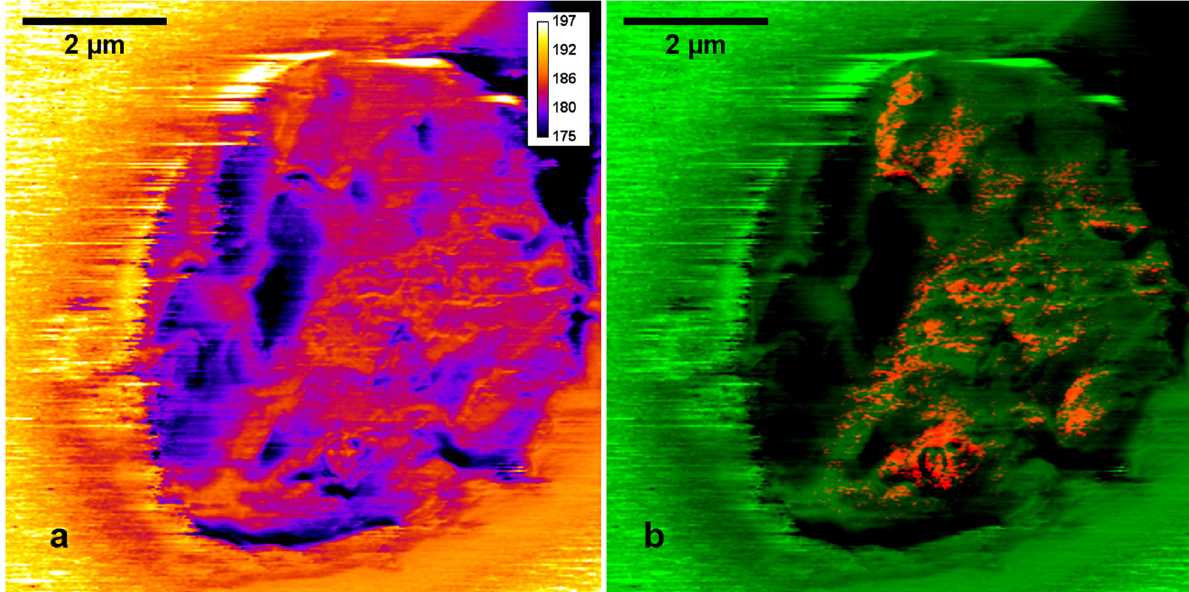
Fig. 6 Co-mapping of local elastic properties with distribution of band characteristic for hematozoin presence in infected RBC. PLL frequency channel recorded simultaneously during AFM-IR experiments ( a ), RGB composite image of PLL frequency (green channel) and 1740 cm − 1 (red channel) distributions ( b